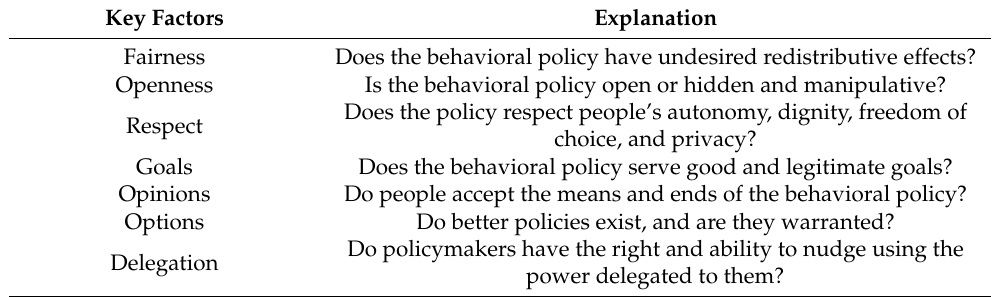
Table 1. The FORGOOD framework. Key